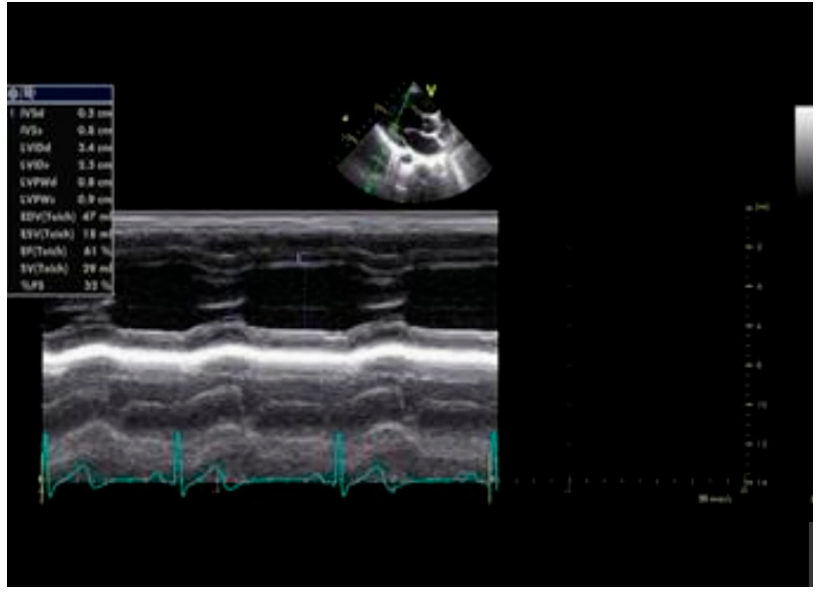
Figure 7. Shows M mode echocardiogram in a healthy child.